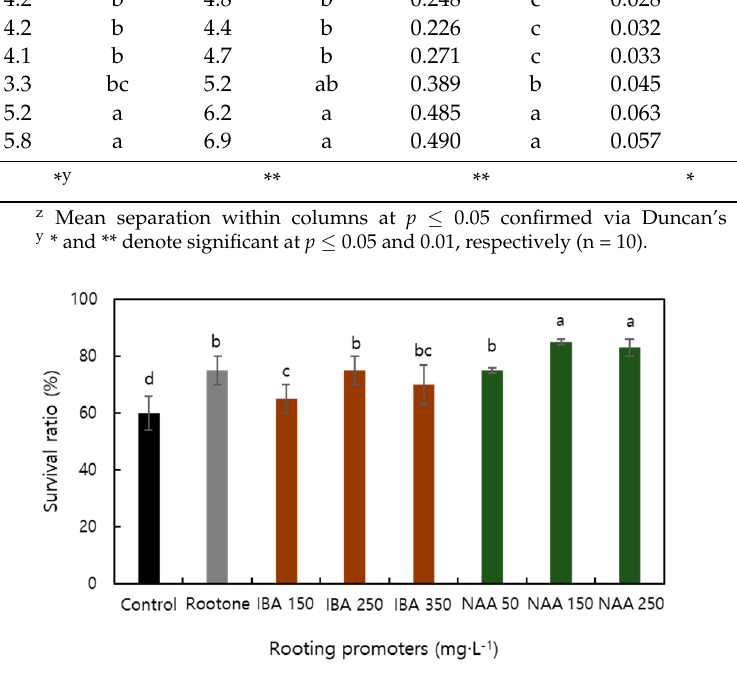
Figure 2. Survival ratio of Rhododendron micranthum Turcz. under rooting promoters. Error bars indicate standard errors (n = 10). Different letters indicate significant differences between treatments according to Duncan’s multiple range test ( p ≤ 0.05).